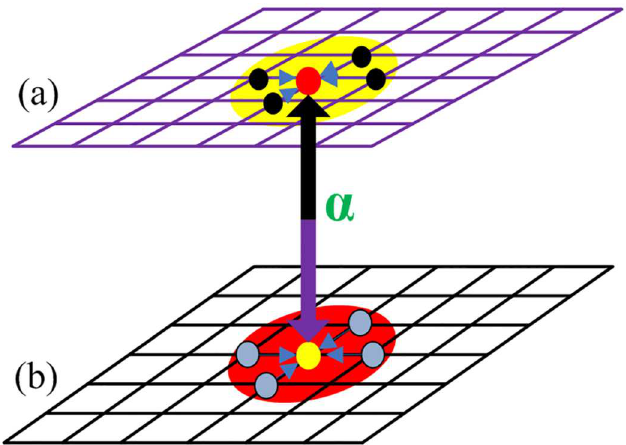
Fig 1. Illustration of one-to-N mapping utility evaluation for interdependent networks. In this model, payoff obtainingand strategy transfer can only take place betweenplayerson the same network. The system consists of two L × L lattices [panel(a) and panel (b)], and the utility or fitness evaluationof the focal agent will be correlated with her own payoff and those of corresponding partners on the other network. As an example, the focal player [red circle in panel (a) or yellow circle in panel (b)] will be coupledwith those in the other network [the red-shadedones in panel (b) or yellow-shaded ones in